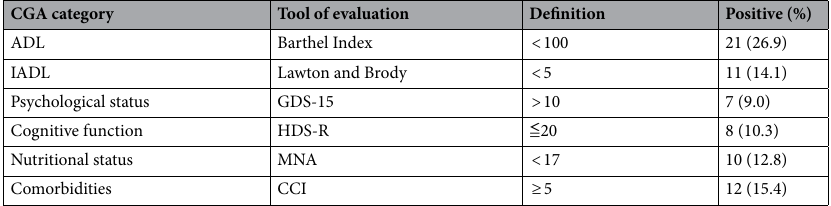
CGA category Tool of evaluation Definition Positive